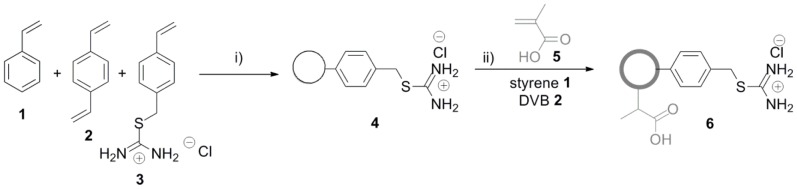
Synthesis of core-shell microspheres.Reaction conditions: i) PVP 58k, azobisisobutyronitrile (AIBN), hexadecane, 70°C, 16 h ii) AIBN, hexadecane, SDS(aq), RT 70°C, 5 h.